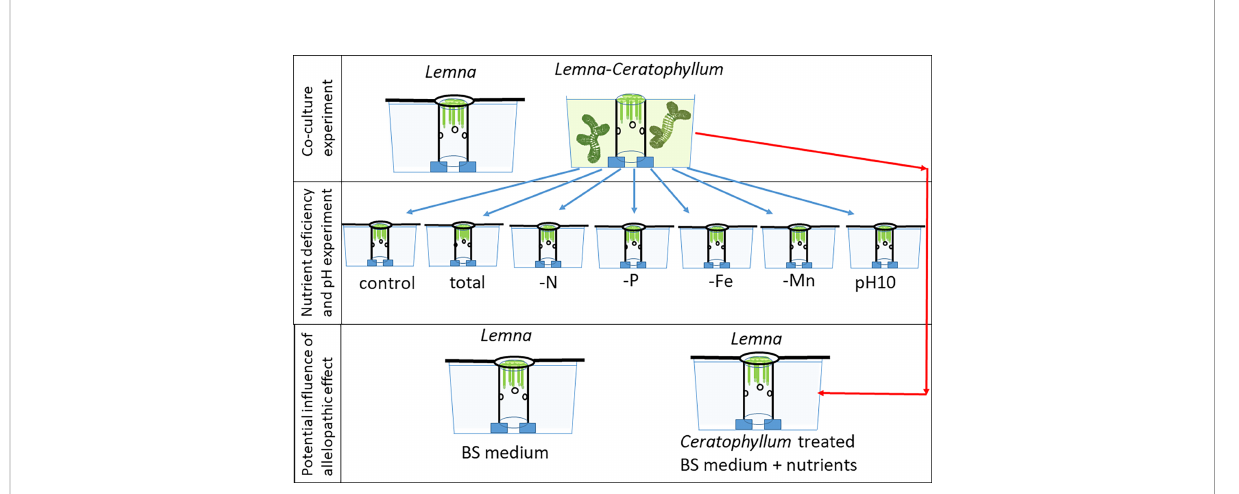
FIGURE 1 Setup of experiments testing the effect of the rootless submerged macrophyte Ceratophyllum demersum on the free- fl oating macrophyte Lemna gibba and disentangling the impact of different nutrient de fi ciencies, pH increases and allelopathic